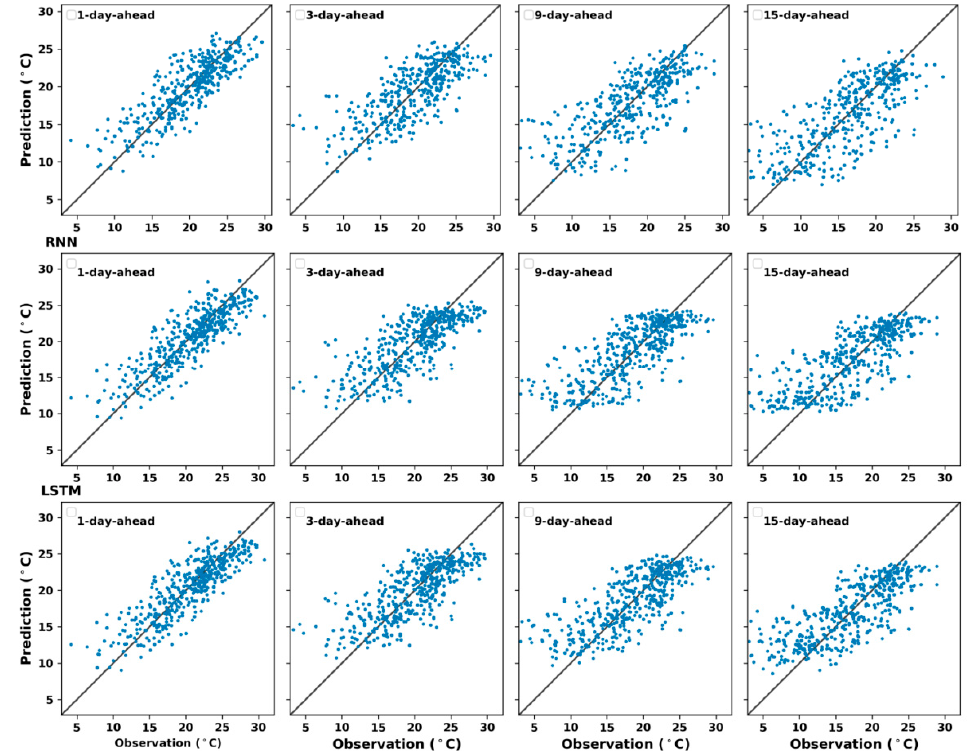
Figure 14. Prediction of k days ahead using ANN ( top ), RNN ( middle ), and LSTM ( bottom ) models for autumn, (cid:1863) = 1,3,9,15 .